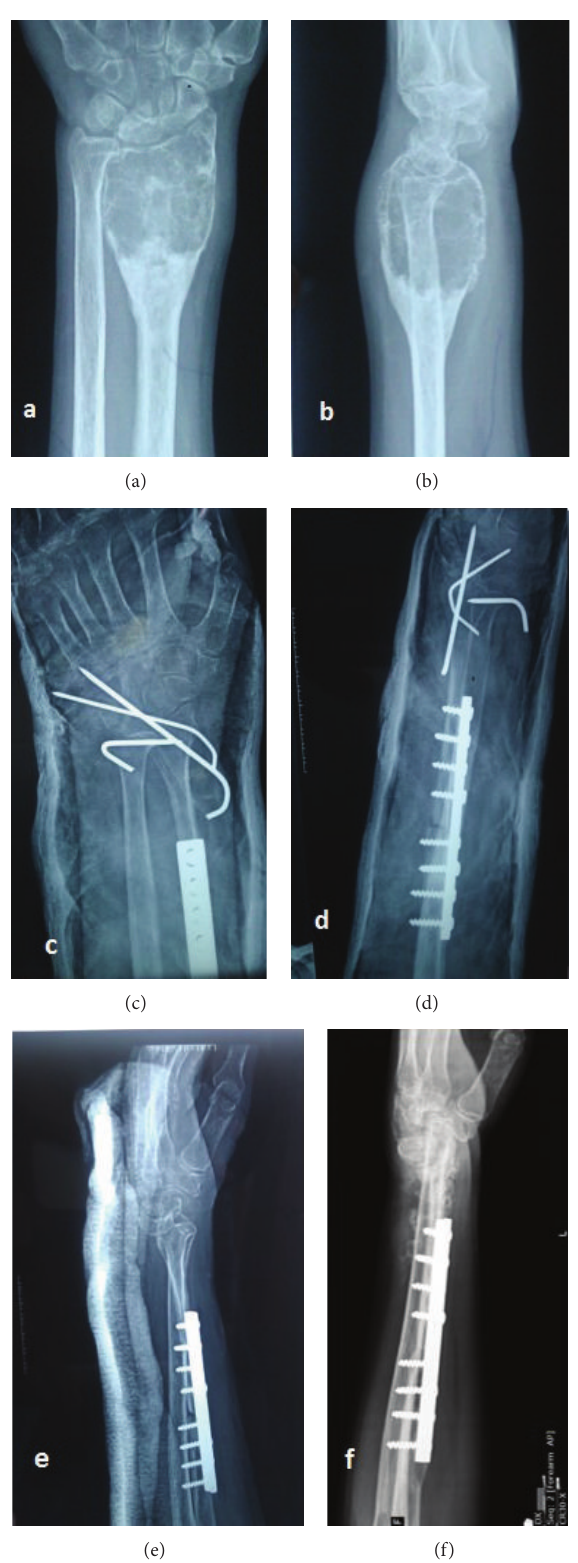
Figure 1: (a and b) Preop plain radiograph of left wrist showing expansile solitary lytic lesion involving left distal radius; (c and d) postoperative radiographs after resection and reconstruction arthroplasty of left wrist; (e) radiographs of her left wrist showing wrist subluxation following k-wire removal; (f) 1 year follow-up radiograph of her left wrist with gross subluxation of